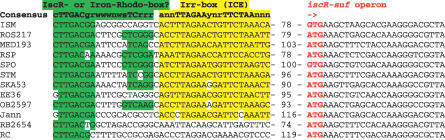
Multiple Alignment of the Upstream Regions of the iscR-suf Operons in the Rhodobacteraceae Species